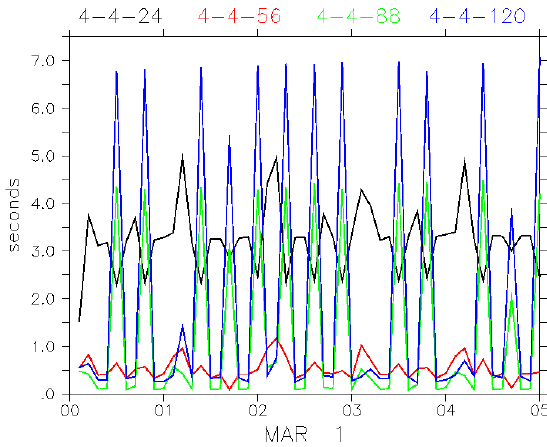
Fig. 7. Average waiting time per task (according to Eq. 1) for the different setups (black: 4-4-24, red: 4-4-56, green: 4-4-88 and 4-4- 120: